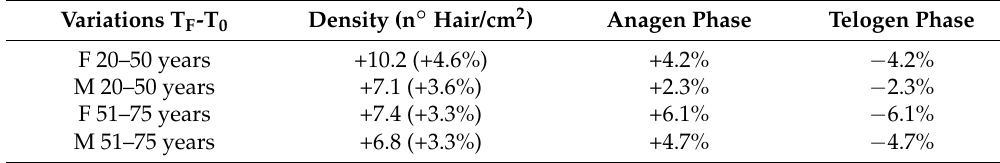
Table 3. Improvements (T F -T 0 ) in hair density and percentage of hair in the anagen/telogen phase at the end of different anti-hair loss cosmetic treatments (lotions, shampoo or diet supplements) as a function of age and